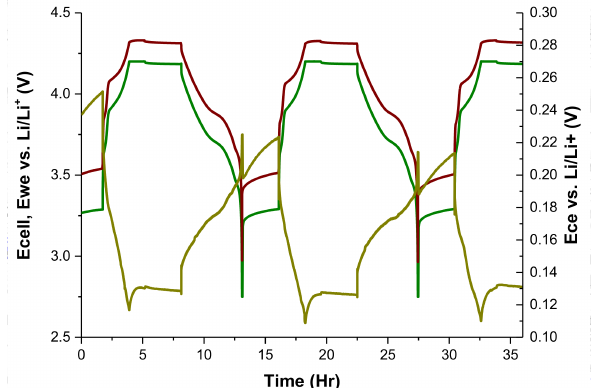
Figure 5. Voltage behavior vs. time of the 18650 cell with RE (green line, left-hand y axis) along with that of the anode (light green line, right-hand y axis) and cathode (brown red line, left-hand y